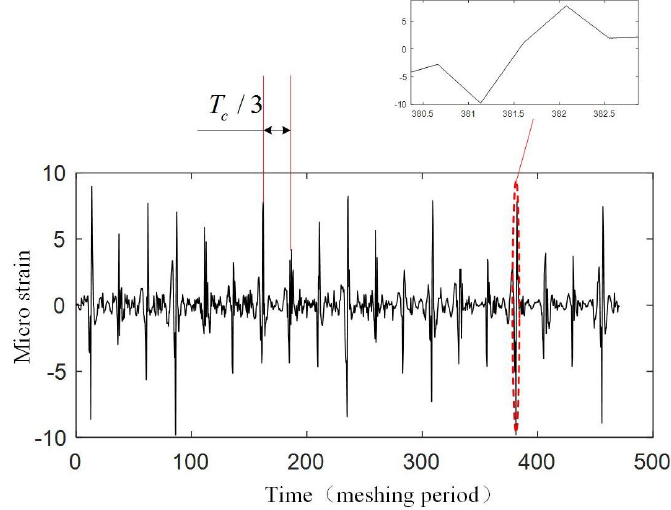
Figure 20. Low-frequency component in the strain signal.